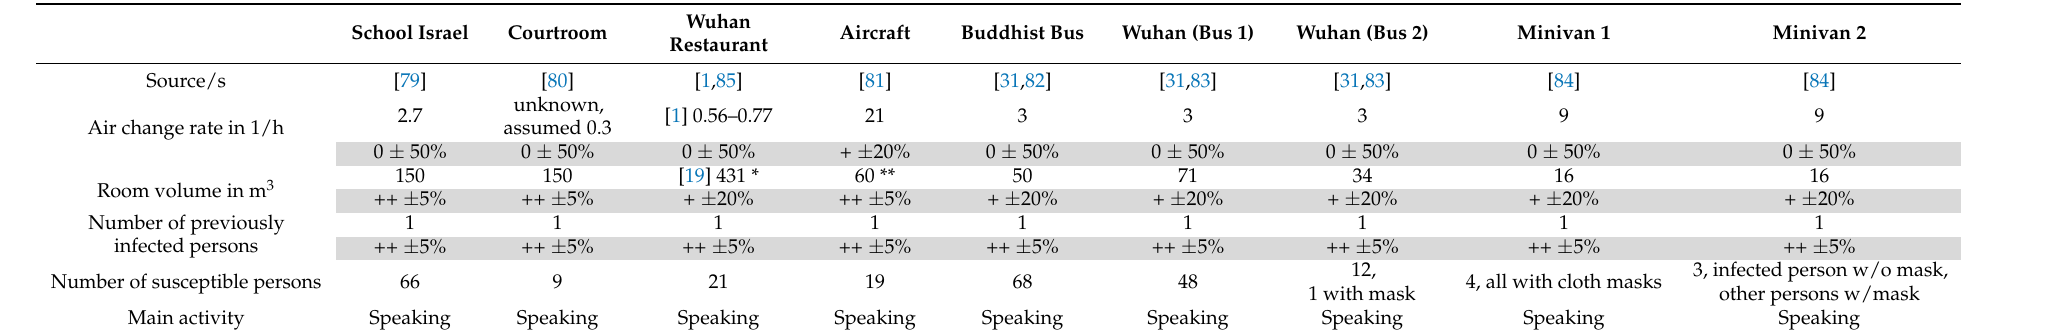
Table A3. Scientifically published SARS-CoV-2